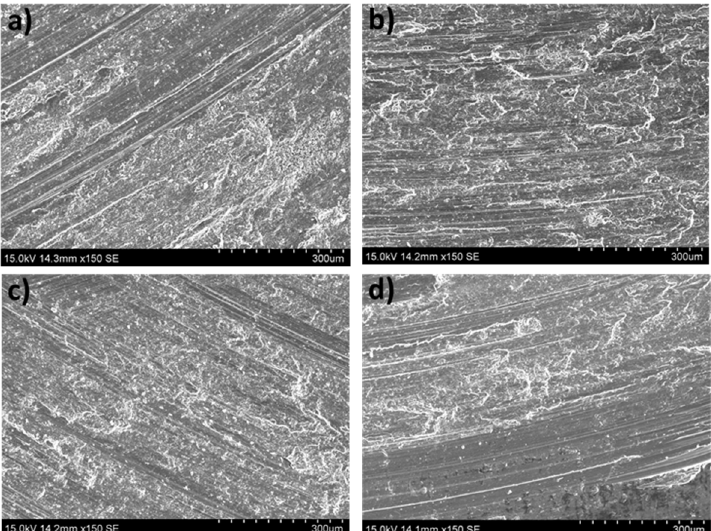
Figure 9. Worn tracks observed for the solution-treated ZX30 alloy under the different wear condi- tions: ( a ) 2 N, 0.05 m s − 1 ; ( b ) 20 N, 0.05 m s − 1 ; ( c ) 2 N, 0.1 m s − 1 ; ( d ) 20 N, 0.1 m s − 1 .